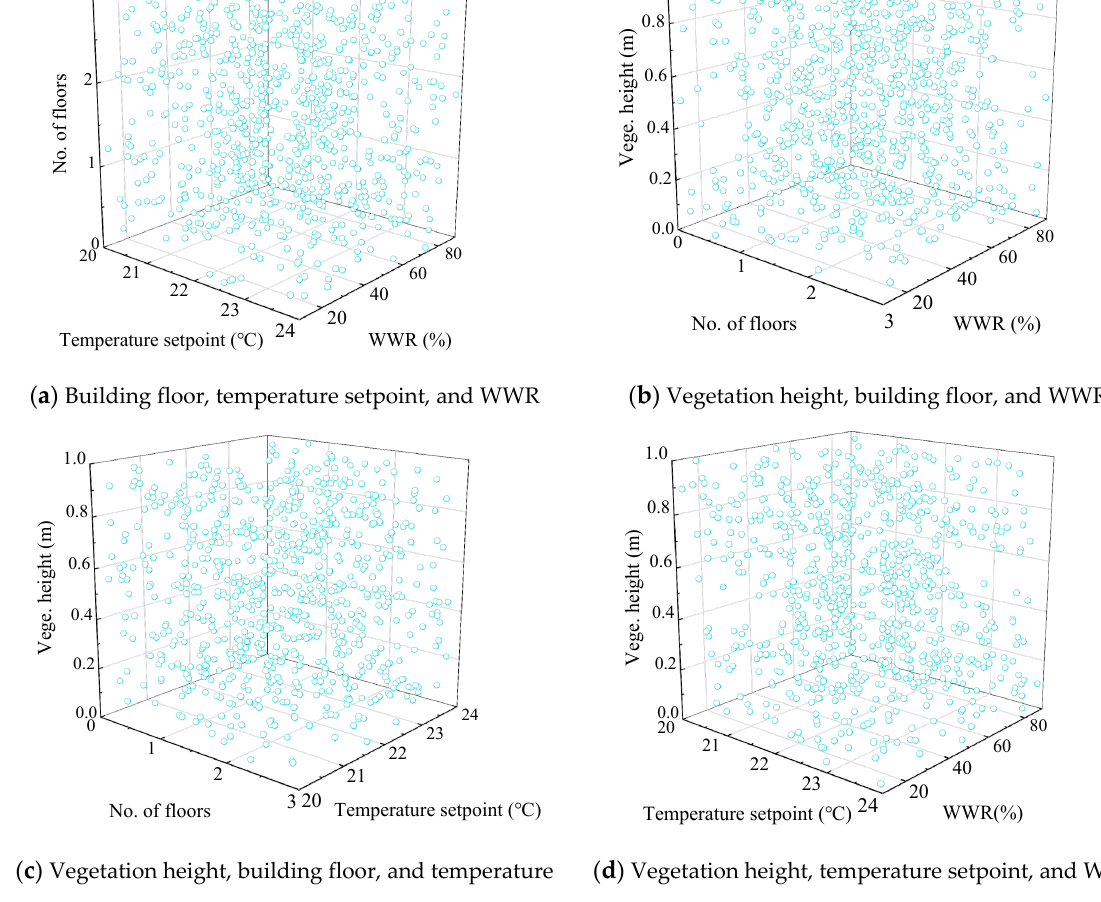
Figure 3. Latin hypercube sampling results of selected design parameters.